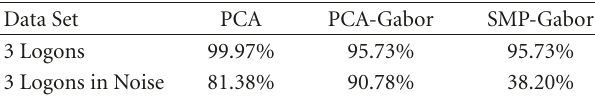
Table 1: The comparison of the variance explained by the PCA, and 3-logons in